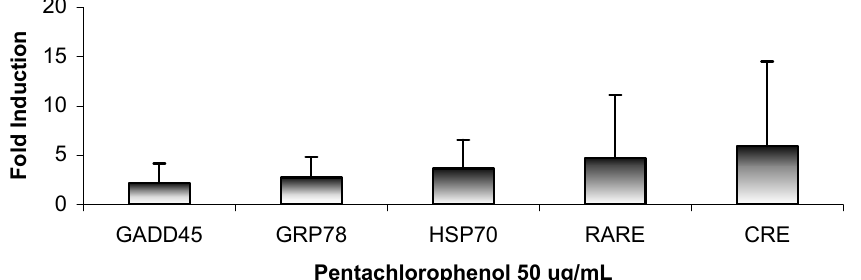
cells exposed 2 cells transfected with a GADD45, GRP78, 2